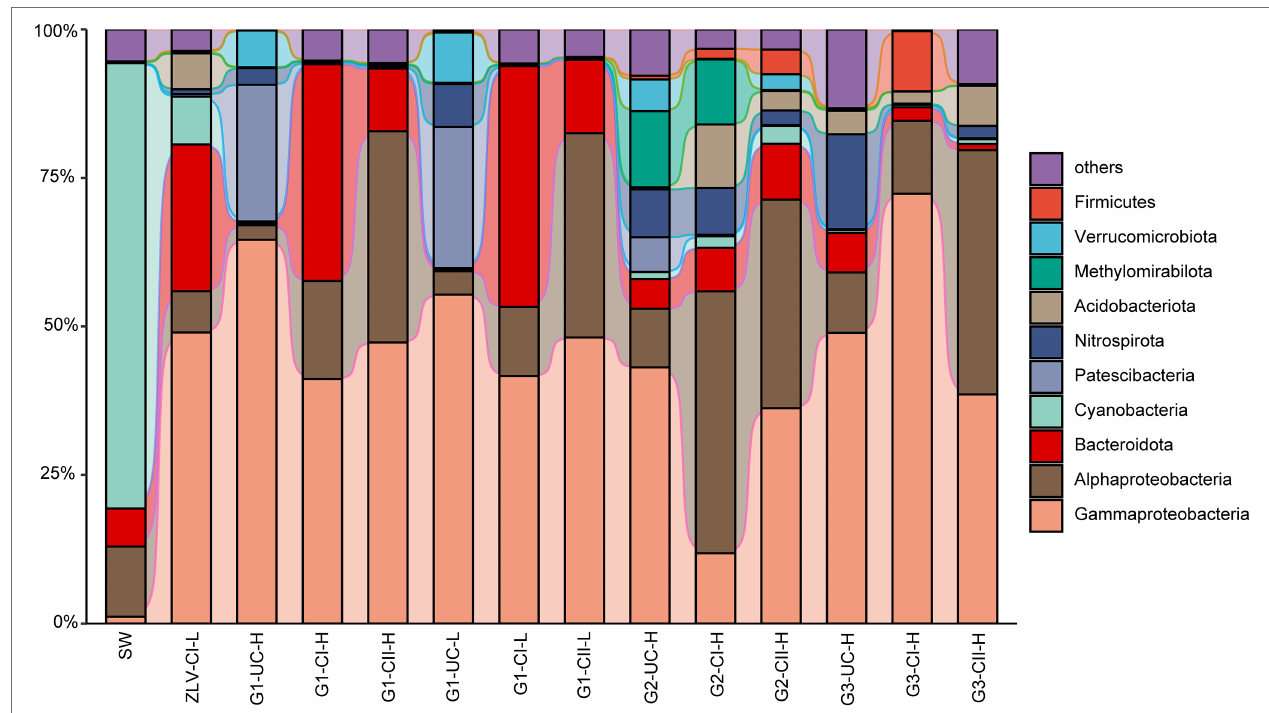
FIGURE 5 | Alluvial bar plot of bacterial community composition and relative abundances. Only the top 10 classes/orders with relative abundance greater than 1% in all the samples are shown with the remaining taxa grouped together as “others” ( Supplementary Figure 3A ). G1, G2 and G3 indicate monitoring site. ZLV, groundwater outlet at Zhuoluo; SW, seawater; UC, unconfined aquifer; CI, confined aquifer I; CII, confined aquifer II; H, high tide; L, low